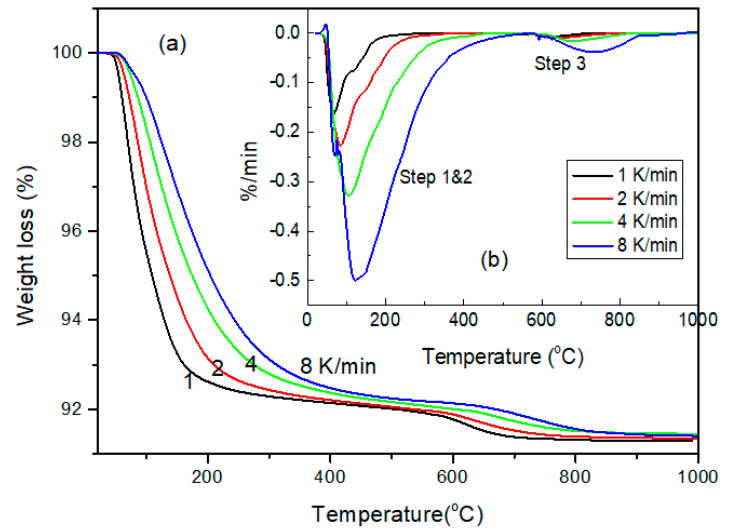
Figure 5. TG ( a ) and DTG ( b ) plots obtained from nonisothermal TGAs of GAC under an ultra-vacuum condition (2 × 10 − 2 Pa) with four di ff erent heating